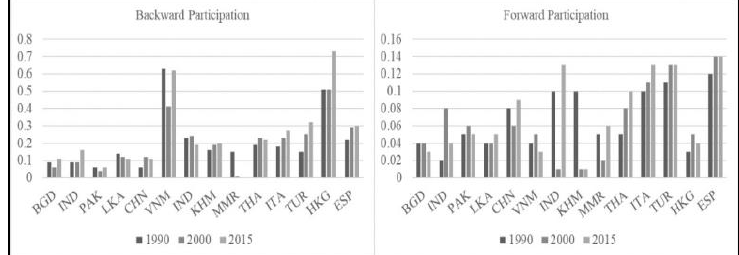
Figure 5: Backward and forward participation of Textile and Apparel sector; Source: